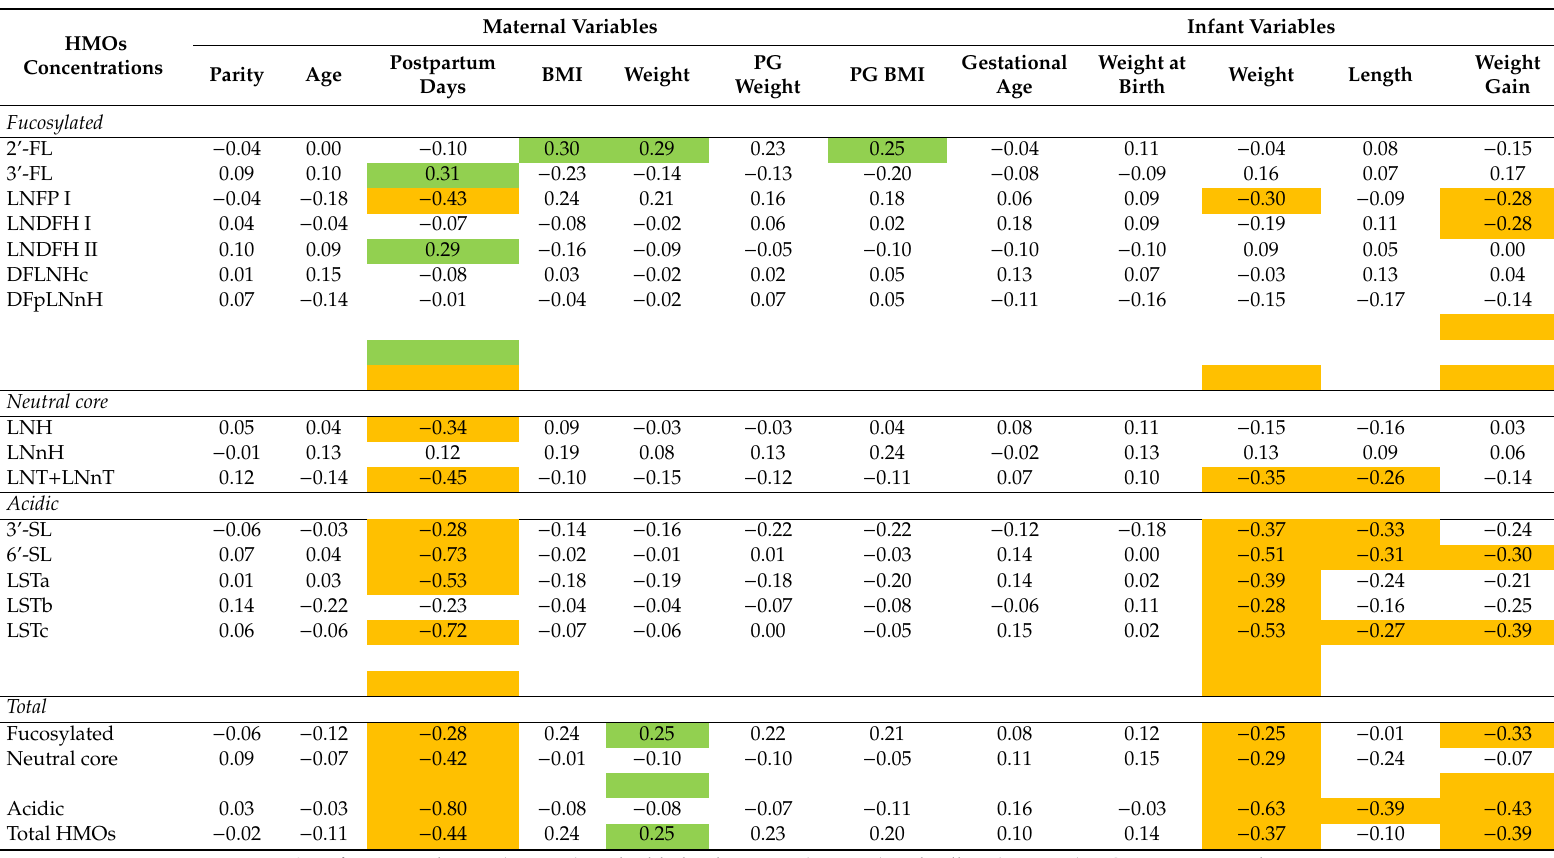
Table A3. Spearman rank correlation coe ffi cient (r) between HMOs concentrations and quantitative clinical variables in Se + women ( n = 68). Maternal Variables Infant HMOs Concentrations